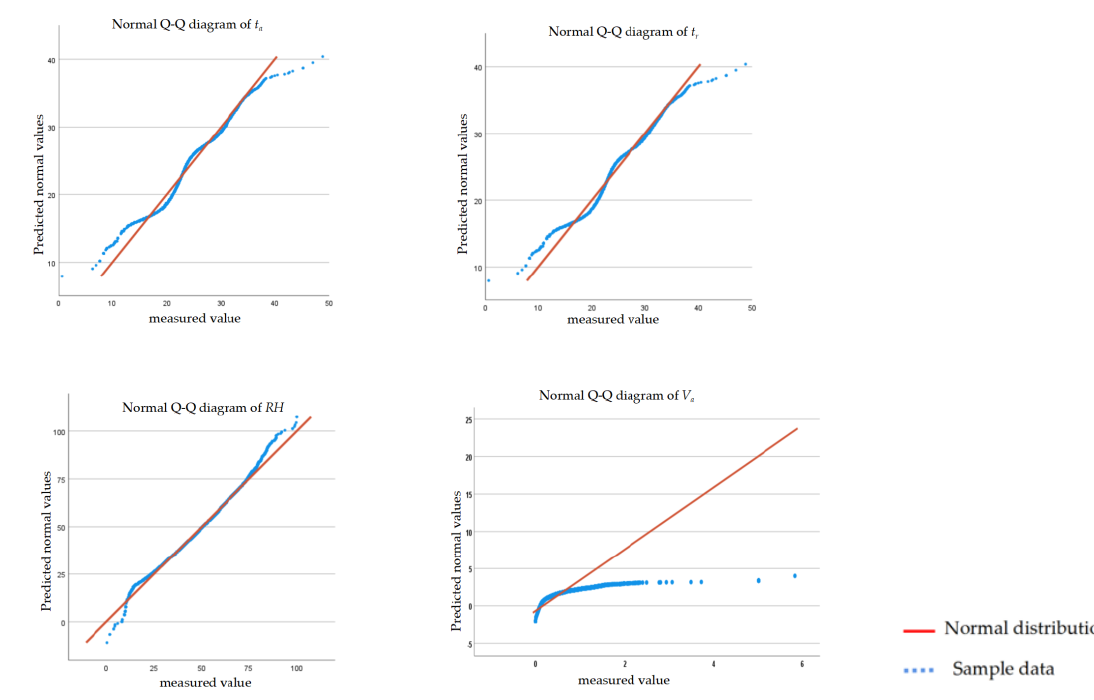
Figure 2. Normal Q-Q diagram of correlated factors.